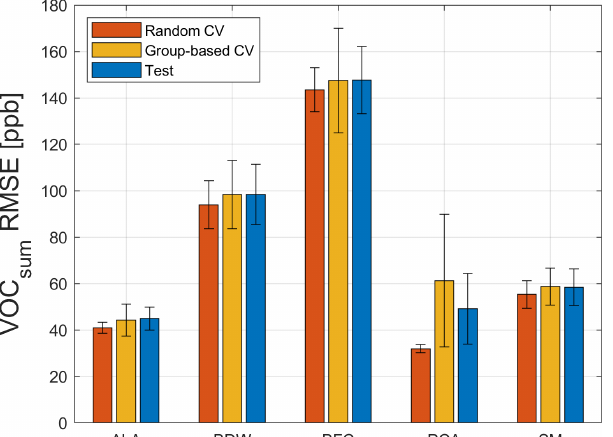
Figure A3. Random CV, group-based CV, and test RMSE of the five FE algorithms, using Pearson as FS and PLSR with n comp = 20 for 100 trials with different data splits and the VOC sum concentration as target. ALA is the adaptive linear approximation, BDW is the best Daubechies wavelets, BFC is the best Fourier coefficients, PCA is the principal component analysis, and SM is the statistical moments.